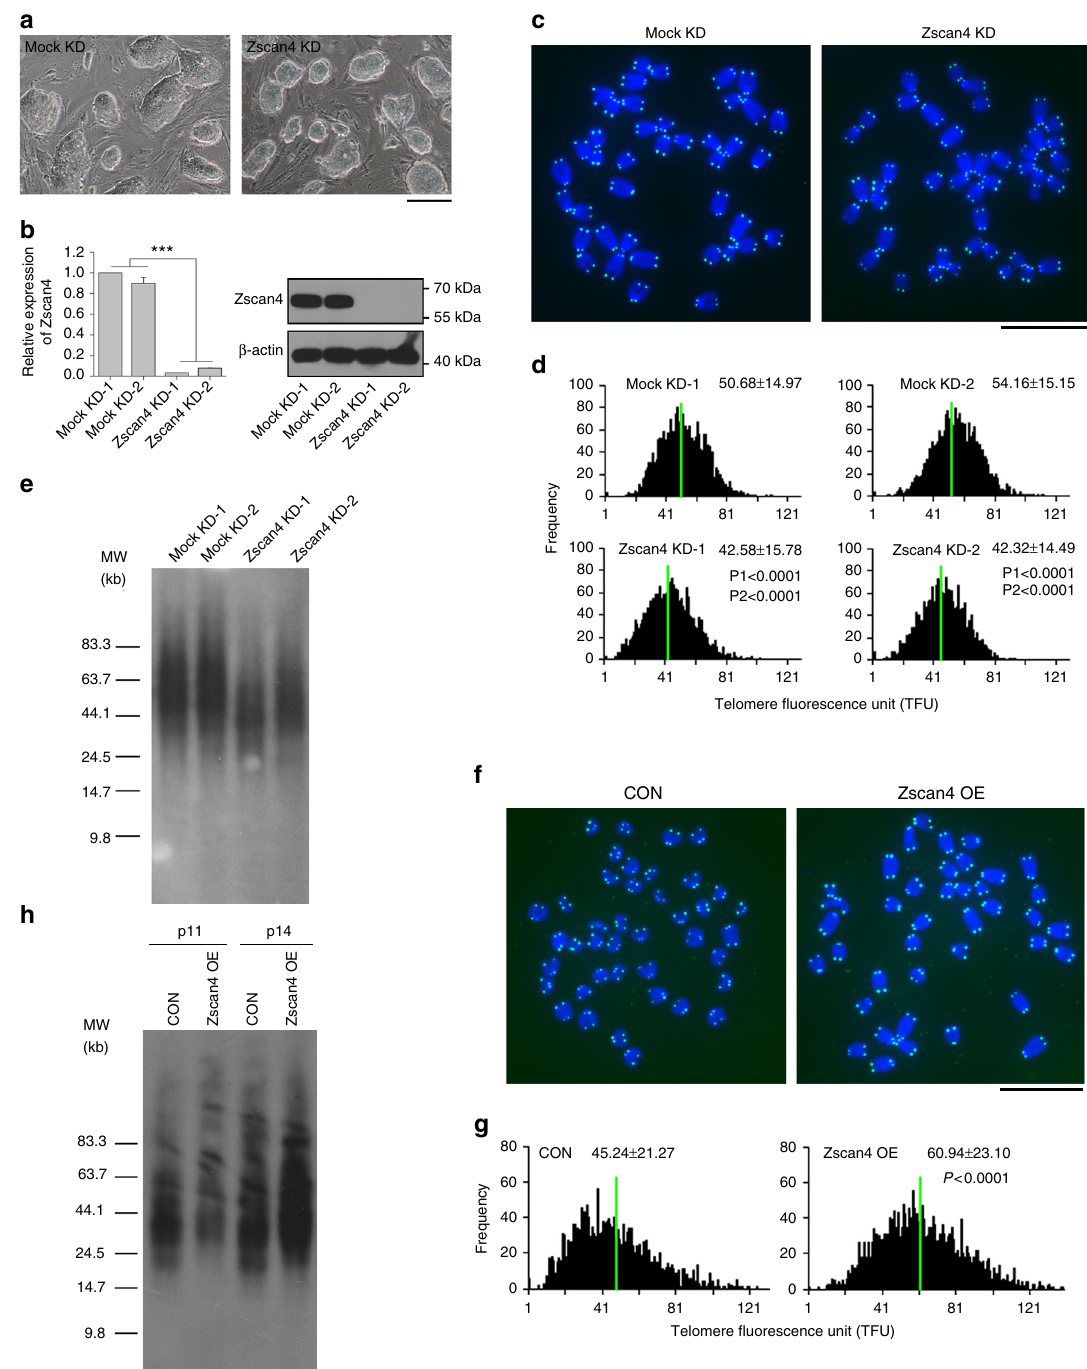
Fig. 3 Knockdown of Zscan4 leads to telomere shortening and overexpression of Zscan4 elongates telomeres. a Colony morphology of control and Zscan4 knockdown (KD) J1 ESCs cultured on feeders, Scale bar, 50 μ m. b Depletion of Zscan4 validated by qPCR and western blot after stable Zscan4 KD for 12 passages. Mean ± s.e.m. *** P < 0.001. Student ’ s t -test. c Representative telomere Q-FISH images of control and Zscan4 KD ESCs. Blue, chromosomes stained by DAPI; green dots, telomeres. Scale bar, 10 μ m. d Histogram shows distribution of relative telomere length displayed as TFU by Q-FISH analysis. Green line indicates medium telomere length. Mean ± s.d. of telomere length is shown above each panel. P1, compared with Mock KD-1, P2, compared with Mock KD-2. Wilcoxon – Mann – Whitney rank sum test. e Telomere length distribution shown as TRF by Southern blot analysis. f Representative telomere Q-FISH images of control and Zscan4 overexpression (OE) J1 ESCs cultured without feeders. Scale bar, 10 μ m. g Histogram shows distribution of relative telomere length displayed as TFU by Q-FISH analysis. Wilcoxon – Mann – Whitney rank sum test. h Telomere length distribution shown as TRF by Southern blot analysis of control and Zscan4 OE ESCs at two indicated passages (P11 and